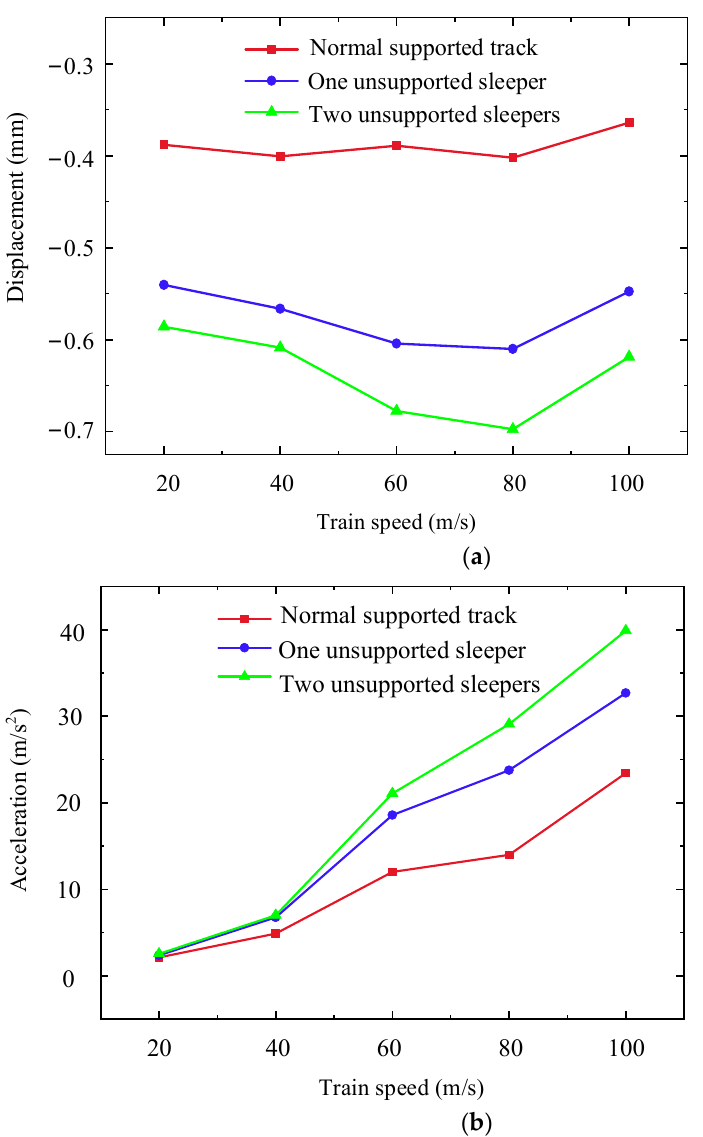
Figure 10. Effect of different speeds on dynamic response of point A under bilateral unsupported sleeper: ( a ) maximum displacement of the track and ( b ) maximum acceleration of the track.